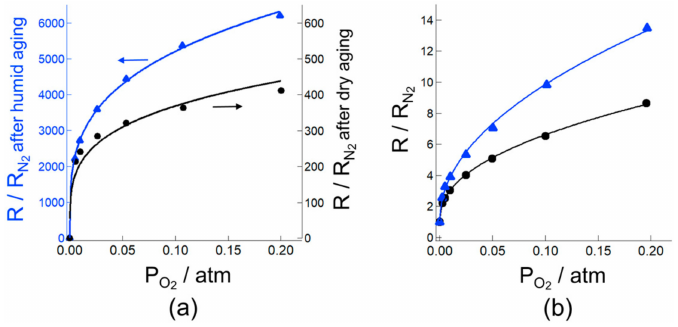
Figure 4. ( a ) The relative resistance (R/R N2 ) at 350 ◦ C in ( a ) dry and ( b ) humid (P H2O ; 0.012 atm) atmosphere as a function of oxygen partial pressure after ( ) dry and ( (cid:78) ) humid aging.